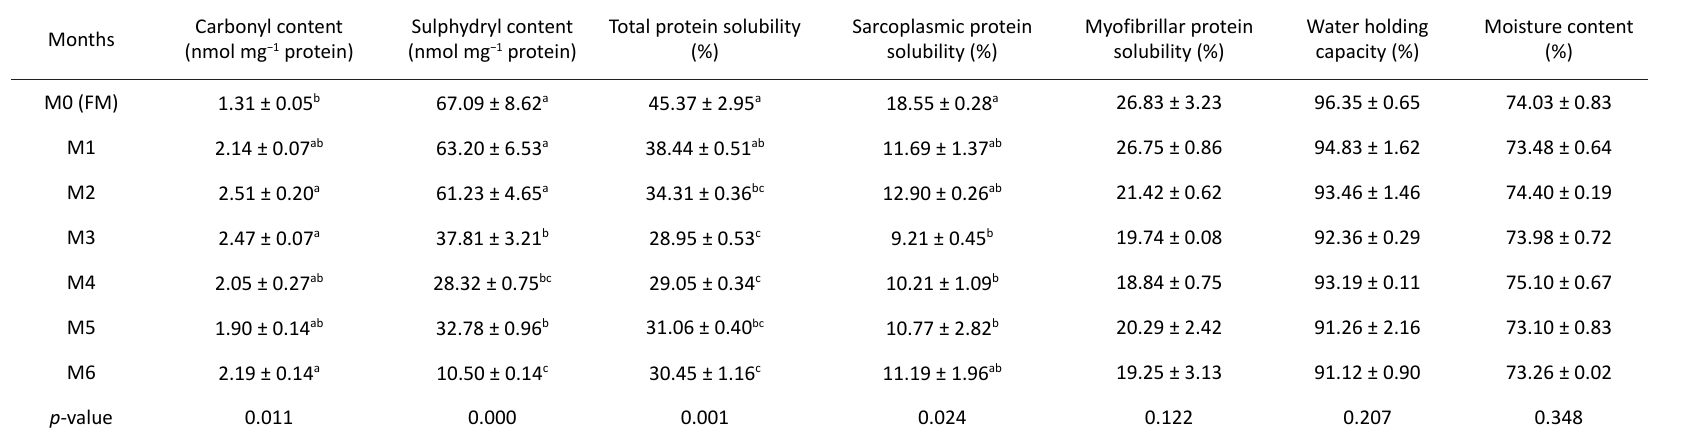
Table 1. Changes in the protein pattern of chicken breast meat within 6 months of frozen storage (n=2) Months